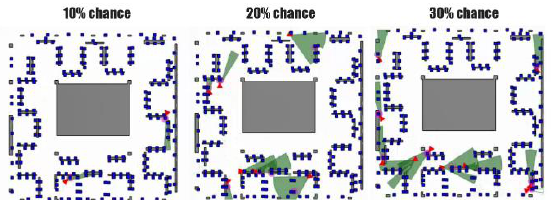
Figure 11. Screenshot of the simulation for 10%, 20%, and 30% chance respectively.